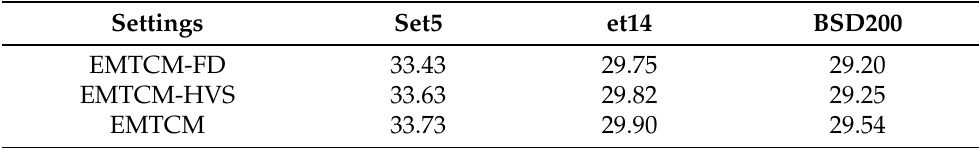
Figure 5. Qualitative comparison between our EMTCM and state-of-the-art SR models with the scale factor 3. ( a ) HR ( b ) Bicubic ( c ) SRCNN ( d ) IRCNN ( e ) SRMD ( f ) RDN ( g ) SRFRN ( h ) Ours. Best viewed zoomed in. Table 6. PSNR under different settings of the loss function on the 91-image dataset with the scale factor